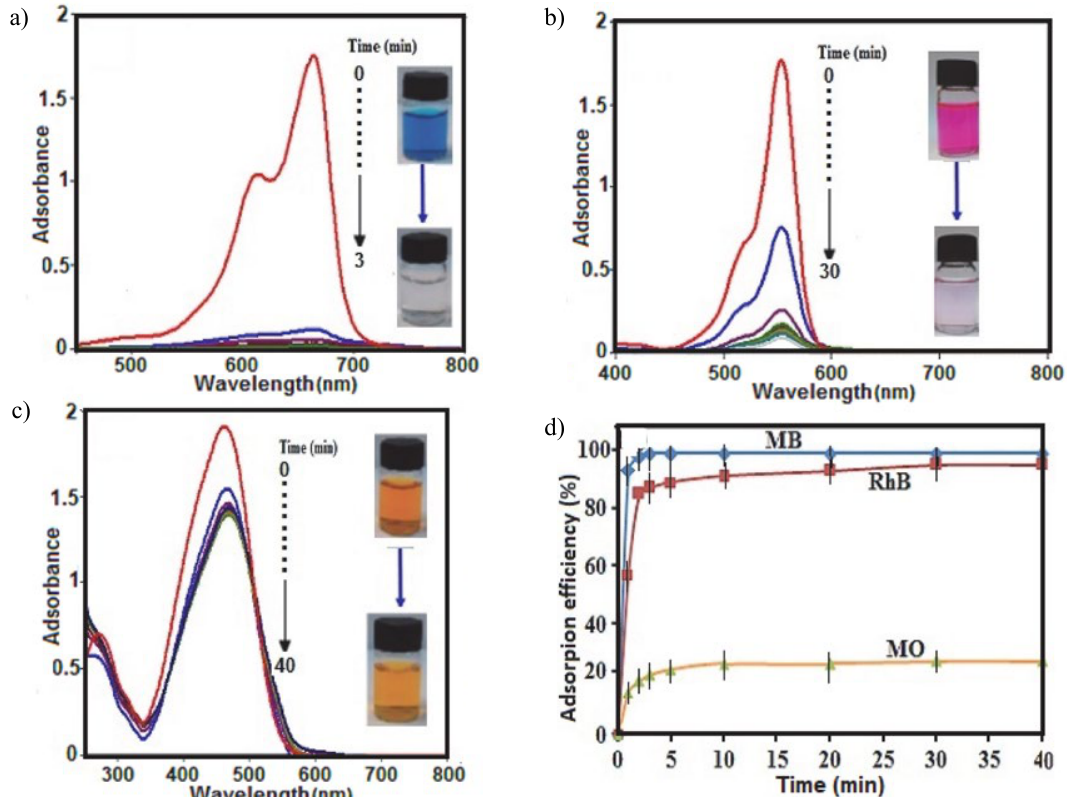
Figure 10. UV-vis spectral changes of dyes aqueous solutions over Fe (c) MO dye and (d) Comparison of adsorption efficiency (%) of dyes as function of time. Conditions: [dye]= 25 mg/L, 50mL; [Adsorbent]= 25 mg/50 mL at 25